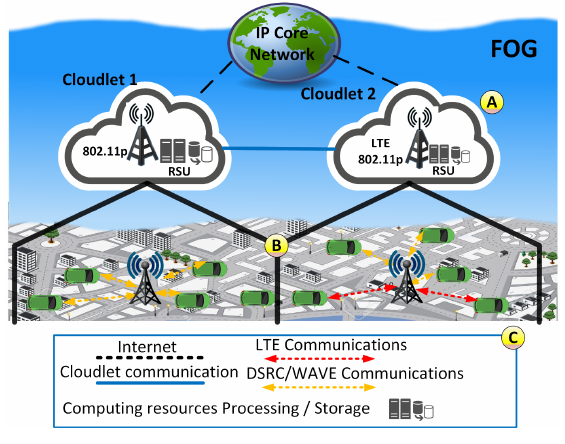
Figure 2. FOXS design.